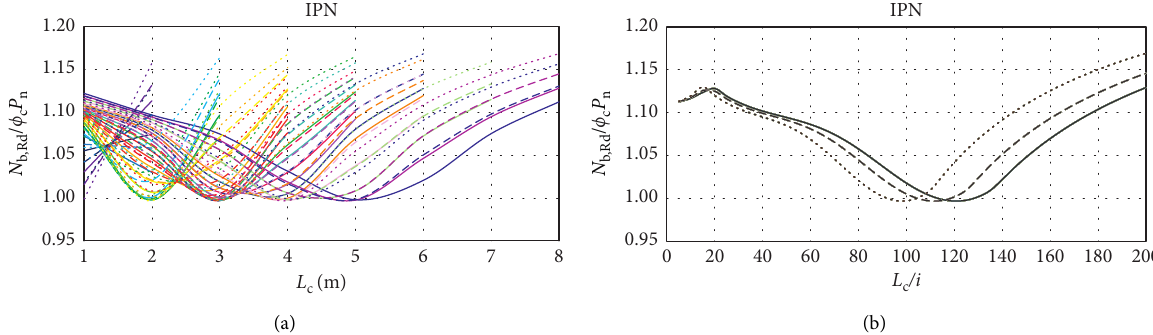
Figure 8: Variation of capacity ratio with buckling length L c (a) and with member slenderness L c / i (b) for studied IPN members. In each plot, the solid, dashed, and dotted curves with identical colours represent the capacity curves plotted for a particular section when the steel grades are S235, S275, and S355, respectively.